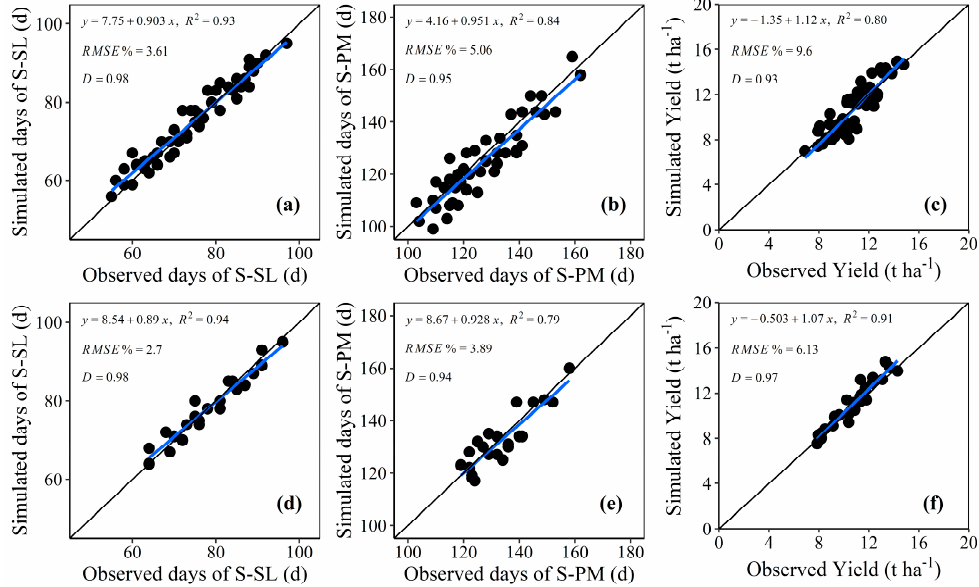
Figure 2. Comparison of measured and simulated values for grain yield, days from sowing to flowering, and days from sowing to physiological maturity: ( a – c ) calibration; ( d – f ) validation. RMSE %: relative root mean square error; D : index of agreement; R 2 : the coefficient of determination.